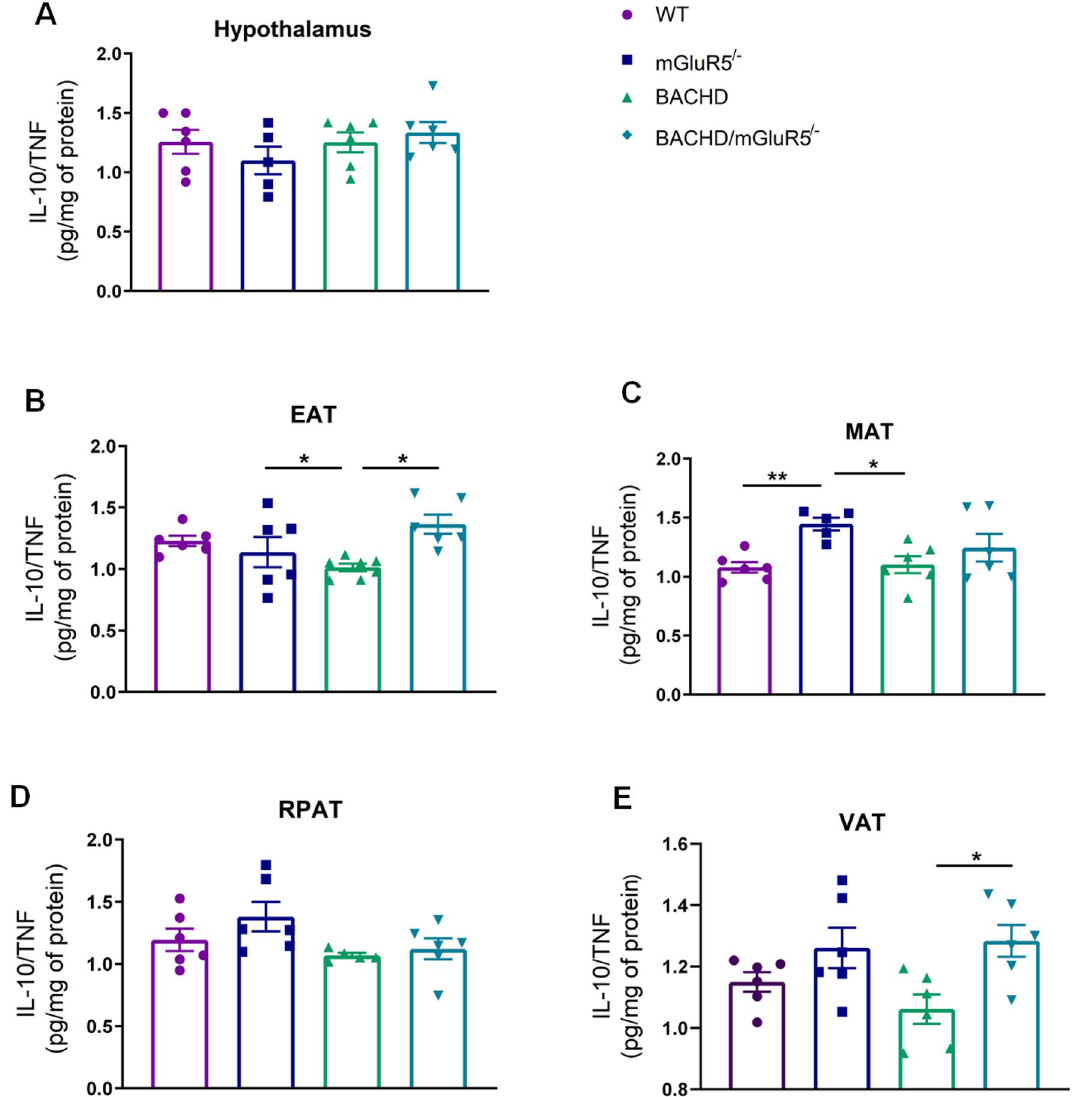
Figure 8. BACHD/mGluR5 −/− mice present an increase of IL-10/TNF ratio in the EAT, and in the sum of visceral adipose tissue. ( A – E ) IL-10/TNF ratio in the hypothalamus, epididymal (EAT), mesenteric (MAT), retroperitoneal (RPAT) adipose tissue, and in the sum of adipose tissues (VAT) of WT, mGluR5 −/− , BACHD and BACHD/mGluR5 −/− mice at 12 months of age. Error bars represent the mean ± SEM; n = 5–7. One-Way ANOVA followed by Bonferroni post-test ( A , E ), and One-Way Welch ANOVA followed by Games-Howell’s post test ( B , C , D ). *p < between IL-4/INF and IL-10/TNF. Importantly, IFN inhibits the production of IL-4 in macrophages, reducing the differentiation of CD4+ naive T cells into type 2 helper T cells, which have an anti-inflammatory role in the context of obesity 45 . Likewise, IL-10 has an anti-inflammatory action, suppressing TNF production 48–51 . In our data, BACHD mice presented a tendency of increasing IL-4/INF levels (p = 0.0537) as compared to WT mice, indicating a pro-inflammatory central milieu. According to our data, mGluR5 did not present changes in IL-4/ INF levels in mostly of the tested tissues. However, literatures shows that the negative modulation of mGluR5 by some drugs is able to decrease the transcription of NF-κB in T cell, TNFα, IL-12p70 and INFγ levels in EAT, which may reduce pro-inflammatory responses mediated by these cells 15,52 . Moreover, our data indicated that the absence of mGluR5 is associated to a higher IL-10/TNF ratio in the adipose tissue, which may indicate an anti-inflammatory tendency. Importantly, adipocytes produce several cytokines, but do not express mGluR5 53,54 . However, some studies demonstrated that activation of mGluR5 is important for the polarization and differ- entiation of macrophages and T lymphocytes 17,18 . Although we did not show the predominant cell population responsible for producing the cytokines modulated by the absence of mGluR5 in the adipose tissue of the double mutant mice, we suggest that the downregulation of mGluR5 possibly modulate the activation of macrophages and T cells in obese adipose tissue, which might be associated with the remodeling of the adipose tissue and